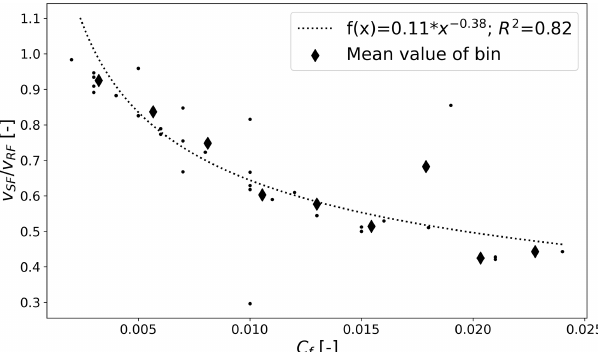
Figure B1. Manning’s n vs. ratio of sheet to rill flow